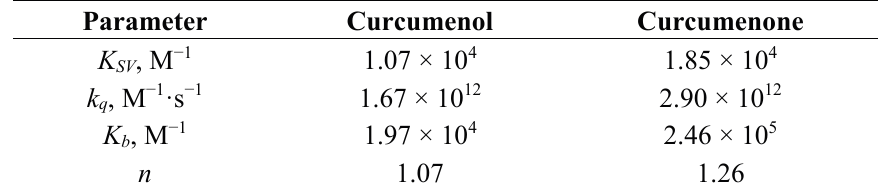
Table 1. Quenching and binding parameters for curcumenol-/curcumenone-HSA interactions, as obtained in 20 mM sodium phosphate buffer, pH 7.4 at 25 °C.